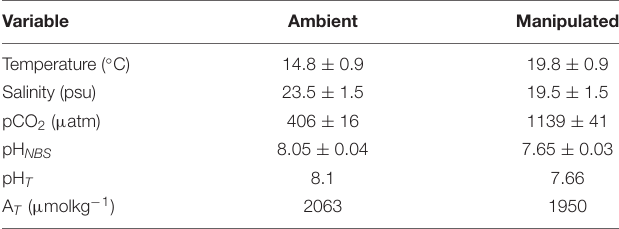
TABLE 1 | Carbonate chemistry parameters of the eight experimental treatments.